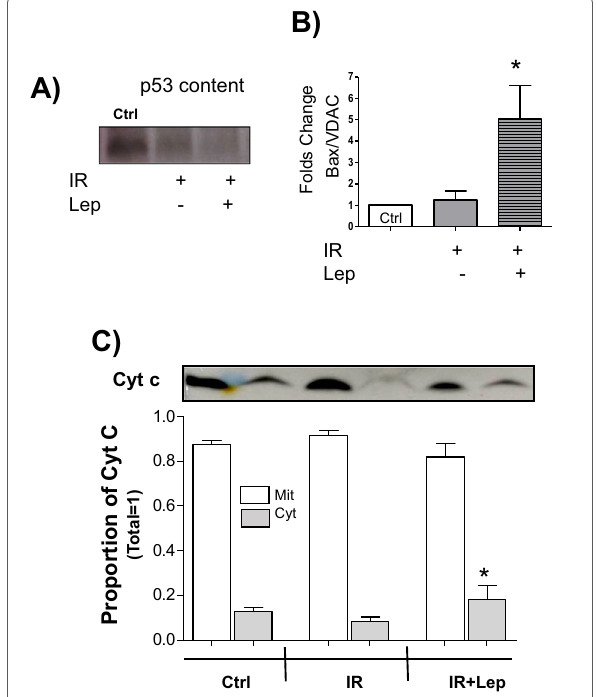
Fig. 5 Effect of leptin on the mitochondrial and cytosolic levels of apoptosis‑associated proteins Bax, p53, and cytochrome c. A p53 content in heart homogenate; the image is representative. B Bax content in isolated mitochondria using VDAC as the loading control. C Cytochrome c content in heart mitochondrial (Mit) and cytosolic fractions of the same heart (Cyt). Values indicate the mean n 3; * p < 0.05. Ctrl control without ischemia; IR ischemia– = reperfusion; Lep